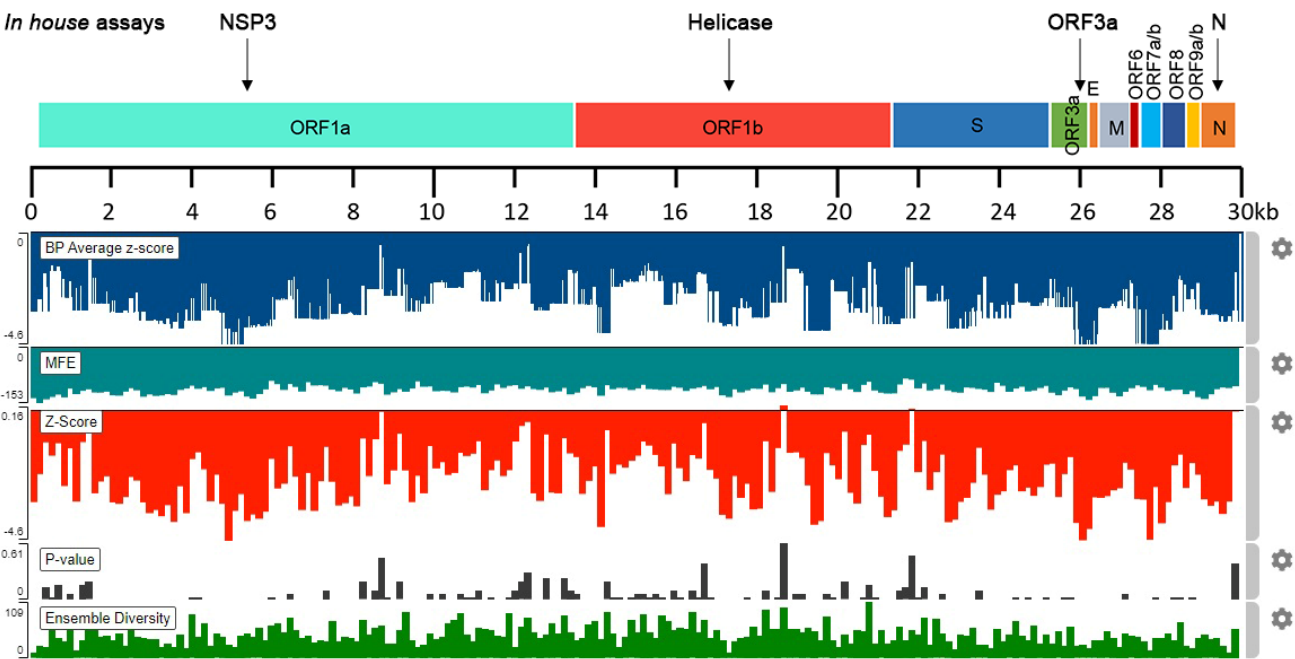
Figure 1. Schematic illustration of the in silico SARS-CoV-2 RNA stability analysis with the ScanFold algorithm, indicating the highly predicted regions targeted by our nested PCR/real-time PCR detection assays (NSP3, helicase, ORF3a, and N detection assays).